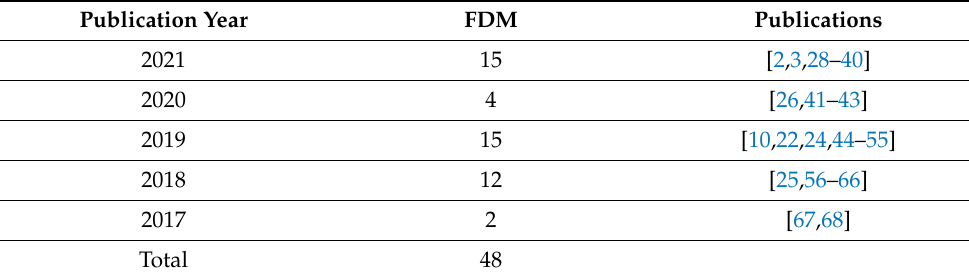
Table 1. List of Data-Driven Solution Papers for FDM